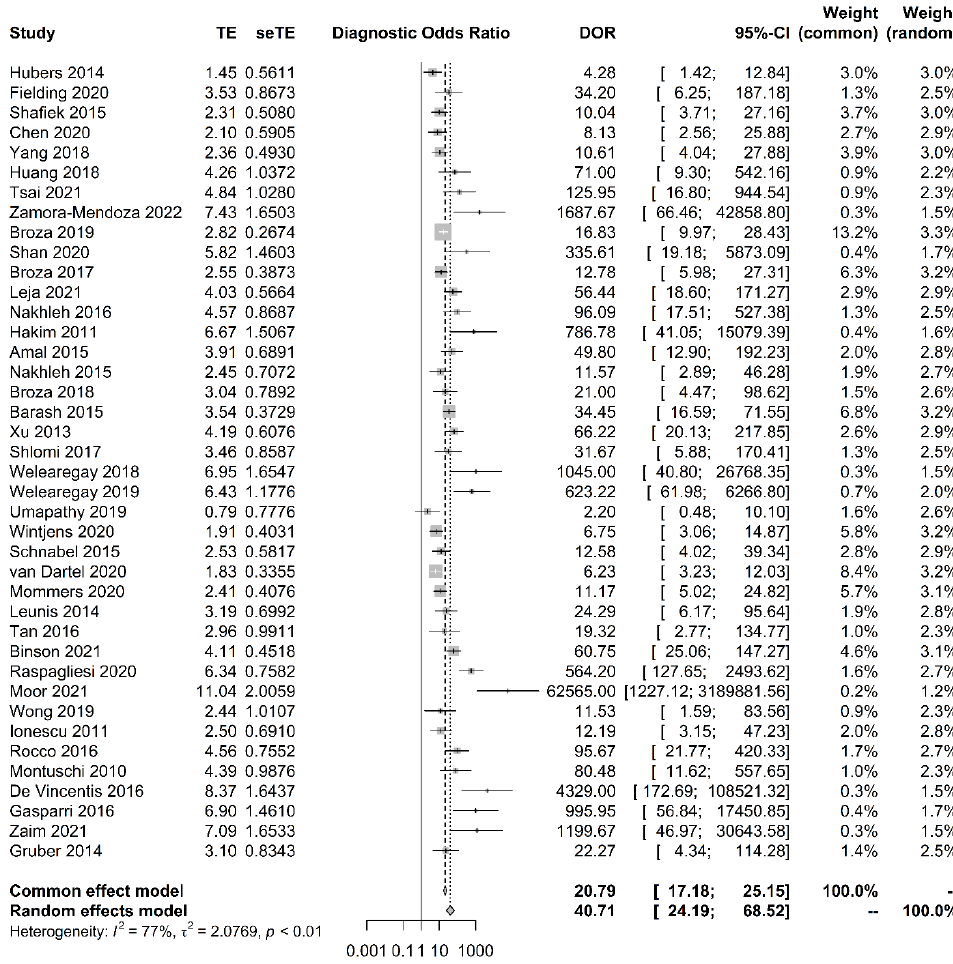
Figure 3. Forest plot and pooled diagnostic odds ratio analysis. Vertical dashed lines indicate 95% CI for the pooled effect. The size of the data markers reflects the weight. Error bars indicate 95% CI.